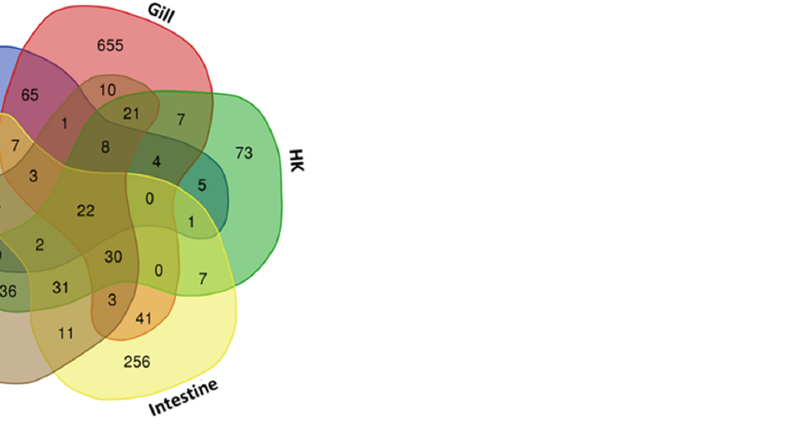
Figure 1. Venn diagram of gene sets in common carp treated under hypoxic conditions: Overlapping 22 genes in five organs are shown in the center, and each organ-specific gene is shown in the corners. HK: head kidney.